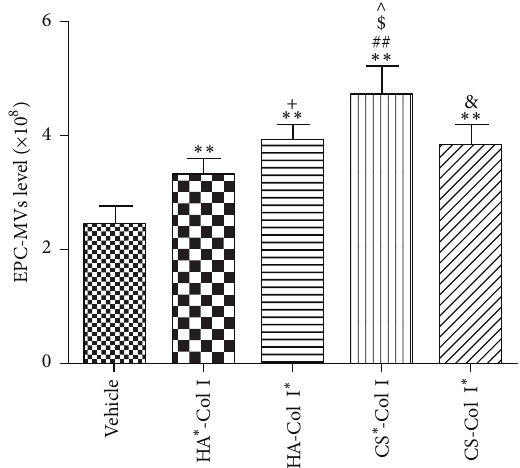
Figure 5: Effects of multilayer composite biomaterial membranes on the release of EPC-MVs. EPC-MVs level from CS ∗ -Col I group was higher than that from other biomaterial membrane groups. The level of EPC-MVs from HA-Col I ∗ group was higher than that from HA ∗ -Col I group, and EPC-MVs level from CS-Col I ∗ group was lower than that from CS ∗ -Col I group. ∗∗ 𝑝 < 0.01 versus vehicle, ## 𝑝 < 0.01 , $ ,∧ 𝑝 < 0.05 versus HA ∗ -Col I, HA-Col I ∗ , or CS-Col I ∗ , + 𝑝 < 0.05 versus HA ∗ -Col I, and & 𝑝 < 0.05 versus CS ∗ -Col I, 𝑛 = 3 /group.